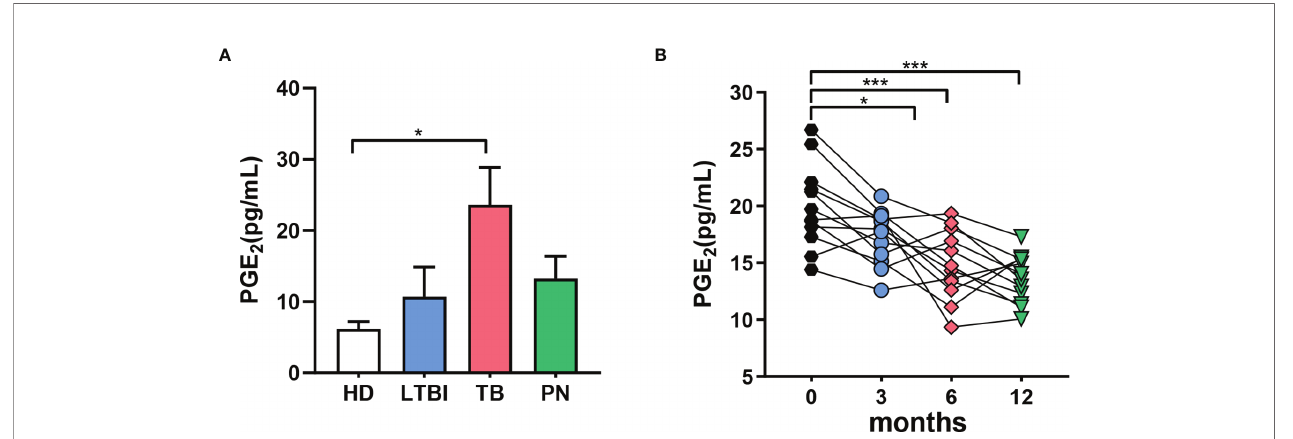
FIGURE 3 | Increased levels of PGE 2 are associated with active TB in humans. (A) Concentrations of PGE 2 in the plasma of humans determined by ELISA; healthy donors (HD, n = 10), latent TB infection (LTBI, n = 10), pulmonary tuberculosis (TB, n = 10), subjects suffering from non-TB lung disease (non-TB, n = 10). (B) PGE 2 levels in the plasma of active TB patients at the indicated time points after initiation of anti-TB chemotherapy, determined by ELISA; ‘ m ’ represents months of antibiotic treatment. *p ≤ 0.05, ***p ≤